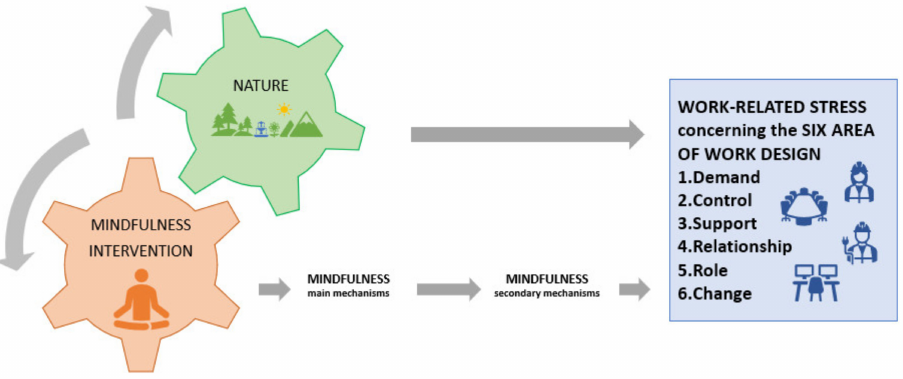
Figure 1. How does Mindfulness in Nature-Based Intervention works to mitigate work-related